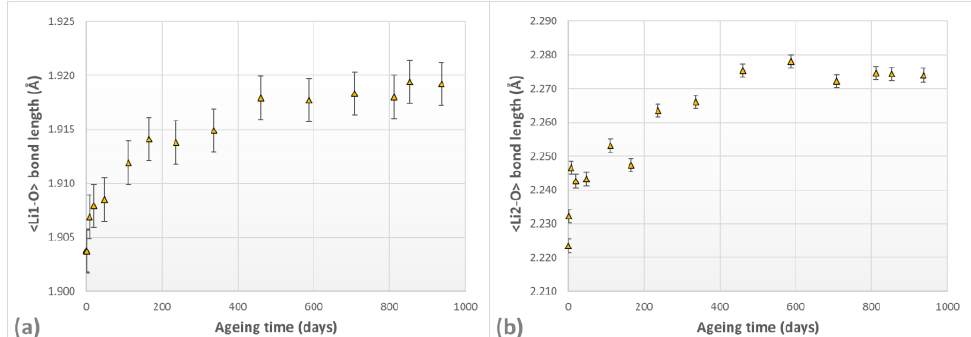
Figure 7. Variation of the average Li-O bond lengths at the ( a ) 24 d (Li1) and ( b ) 96 h (Li2) sites in Al10-LLZO during aging in a moist atmosphere. Note, the same crystal is used and remeasured. To monitor the progress of hydration of Al-stabilized LLZO, aging experiments were performed under mild hydrothermal conditions at 90 °C using different residence times.